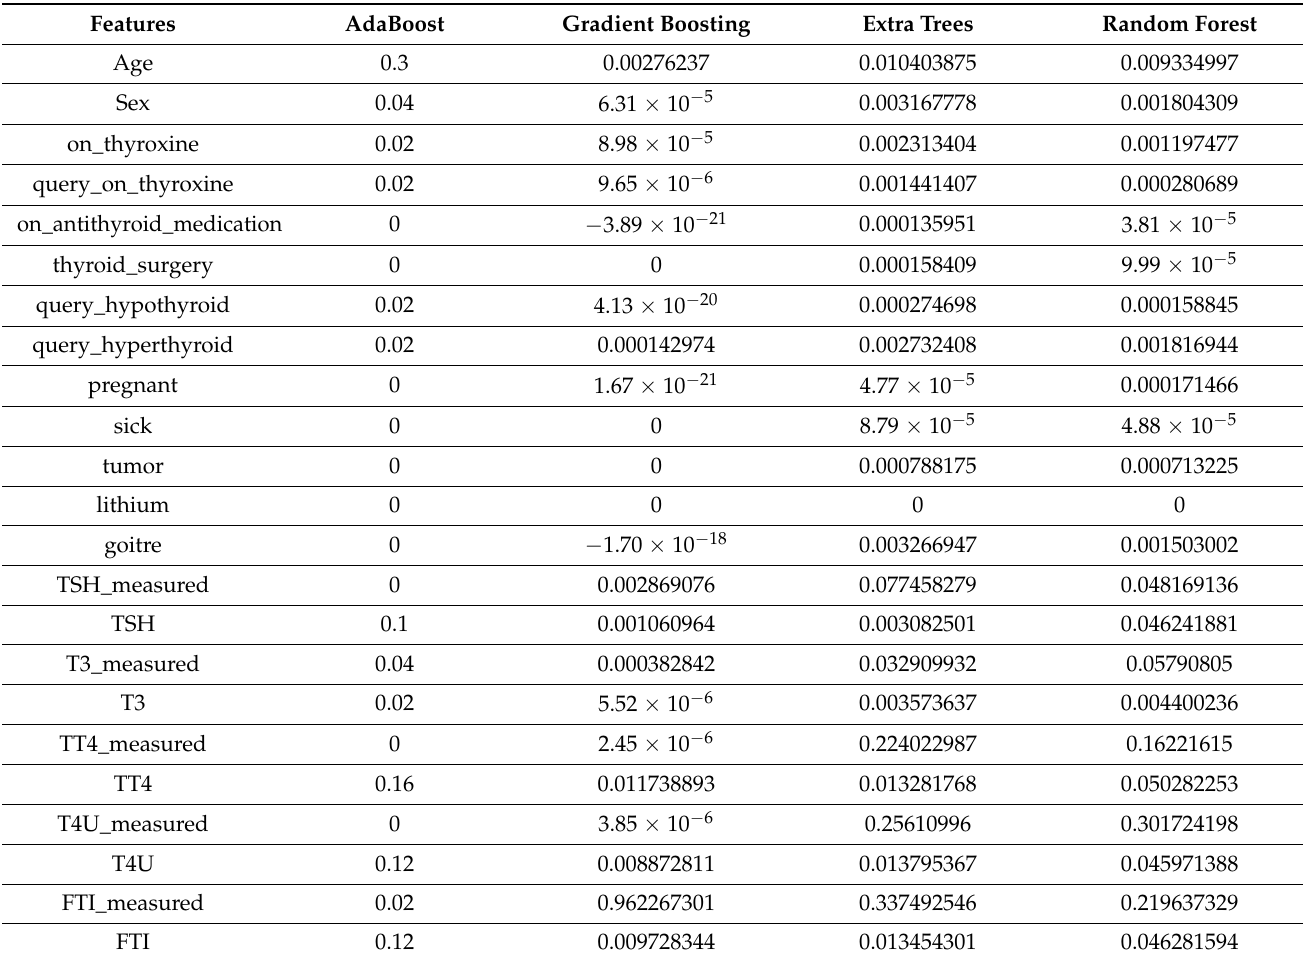
Table 6. Classifier feature importance values of each feature before feature scaling.